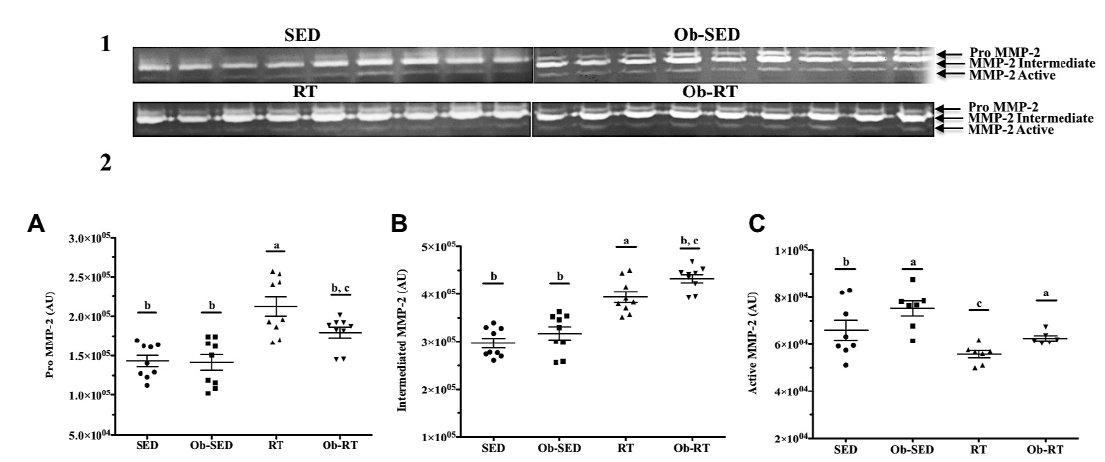
Figure 7 - Effect of high-fat diet and RT on isoforms’ activity of matrix metalloproteinases 2 (MMP-2) in the left ventricle (LV). SED, Sedentary group; Ob- SED, Obese sedentary group; RT, resistance training group; and Ob-RT, obese trained